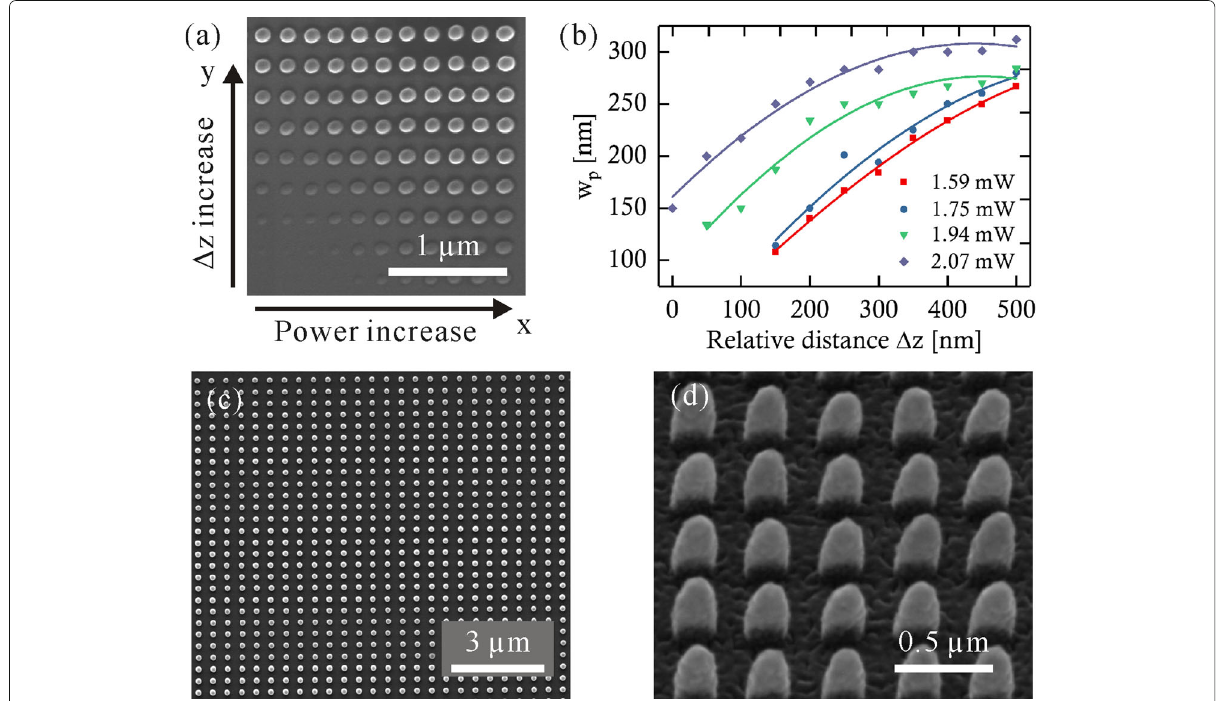
Fig. 8 Pillar arrays fabricated with different laser intensity and laser focus relative distance Δ z . Material: E-shell 300. a SEM image of pillars fabricated with different laser intensity and relative laser focus positions. b Measured pillars diameter w p with respect to the laser intensity I and the relative distance Δ z . Laser intensity is respectively 0.74kW/ μ m 2 , 0.81kW/ μ m 2 , 0.90kW/ μ m 2 , and 0.96kW/ μ m 2 with the correspondence of laser power 1.59mW, 1.75mW, 1.94mW, and 2.07mW. c Top view of the pillar array. d SEM image of the pillar array viewed with 45